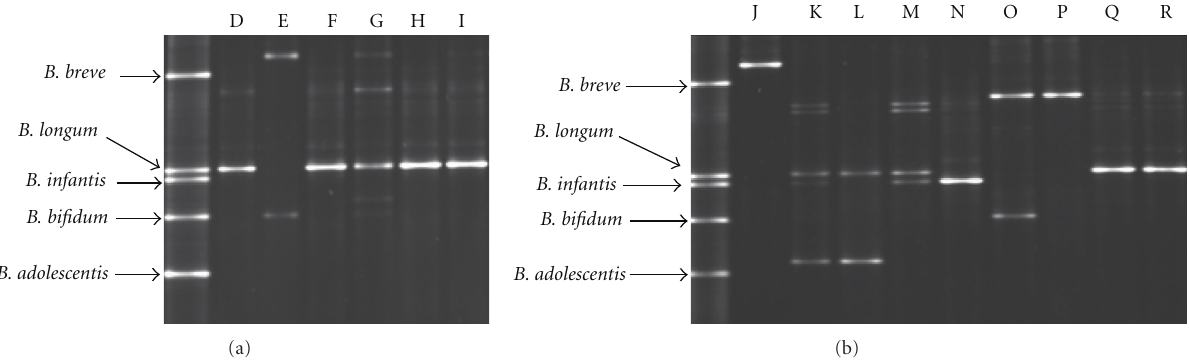
Figure 1: DGGE of bifidobacterial PCR-products (V3-region) from stool samples taken at four weeks of age from infants treated with antibiotics D–I (a) and controls J–R (b). The mobility of the PCR products obtained in DGGE was compared to the PCR pattern of reference strains obtained with the same primer